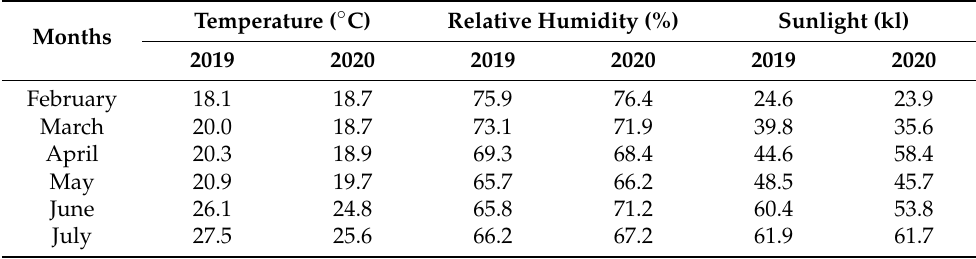
Table 2. Tomato growing conditions